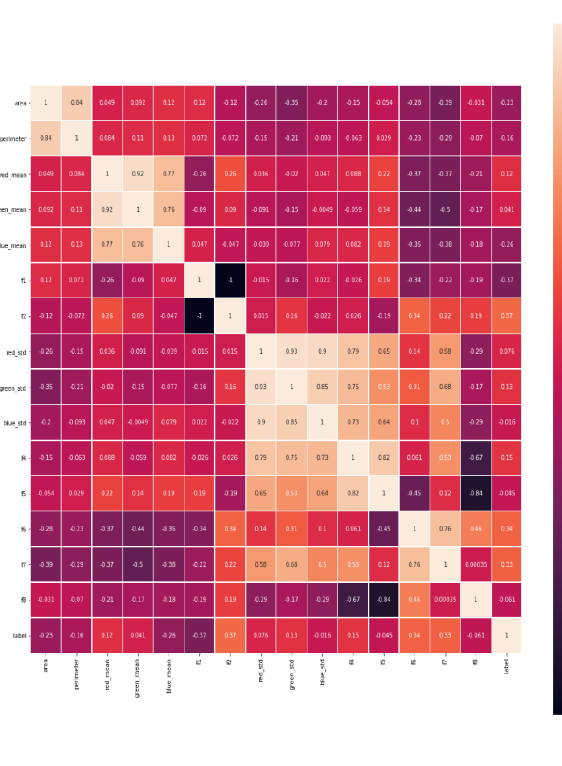
Fig. 3 . Correlation map for apple dataset